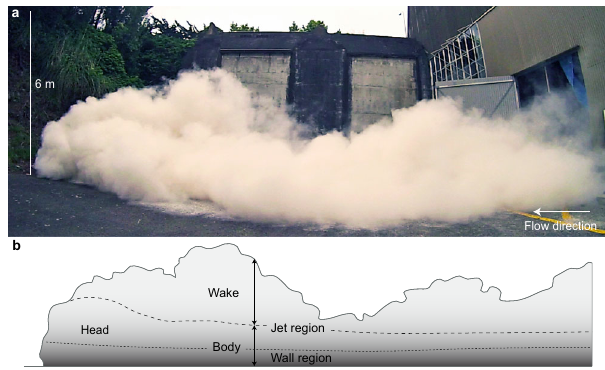
Fig. 1 Synthesizing pyroclastic surges in large-scale experiments. a lateral view of an advancing experimental pyroclastic surge at the eruption simulator PELE. b Schematic sketch of the internal fl ow structure shown in Fig. 1a. This illustrates the longitudinal subdivision of the gravity current into the frontal head and trailing body regions; and the vertical structure of the gravity current where the rear of the head and the entire body region are overlain by the gravity current wake. The wide dashed line demarcates the position of the lower boundary of the wake. The narrow-dashed line delineates the position of the fastest velocity magnitude in vertical pro fi les through the current. This position separates the head and body regions into a lower layer dominated by shear with the solid lower fl ow boundary, which is often referred to as the wall region; and an upper region dominated by free shear, which is often termed the jet region. Figure 1 depicts the experimental surge during propagation across the uncon fi ned runout section from c. 16 – 31 m from the impact zone. At this stage, partially buoyant plumes develop across the fl ow length, which continue rising as a phoenix cloud for tens of seconds after the cessation of forward motion of the experimental pyroclastic Table 1 Comparison of bulk fl ow scaling of natural pyroclastic surges 63 – 65 and experimental pyroclastic surges in PELE large- scale experiments.